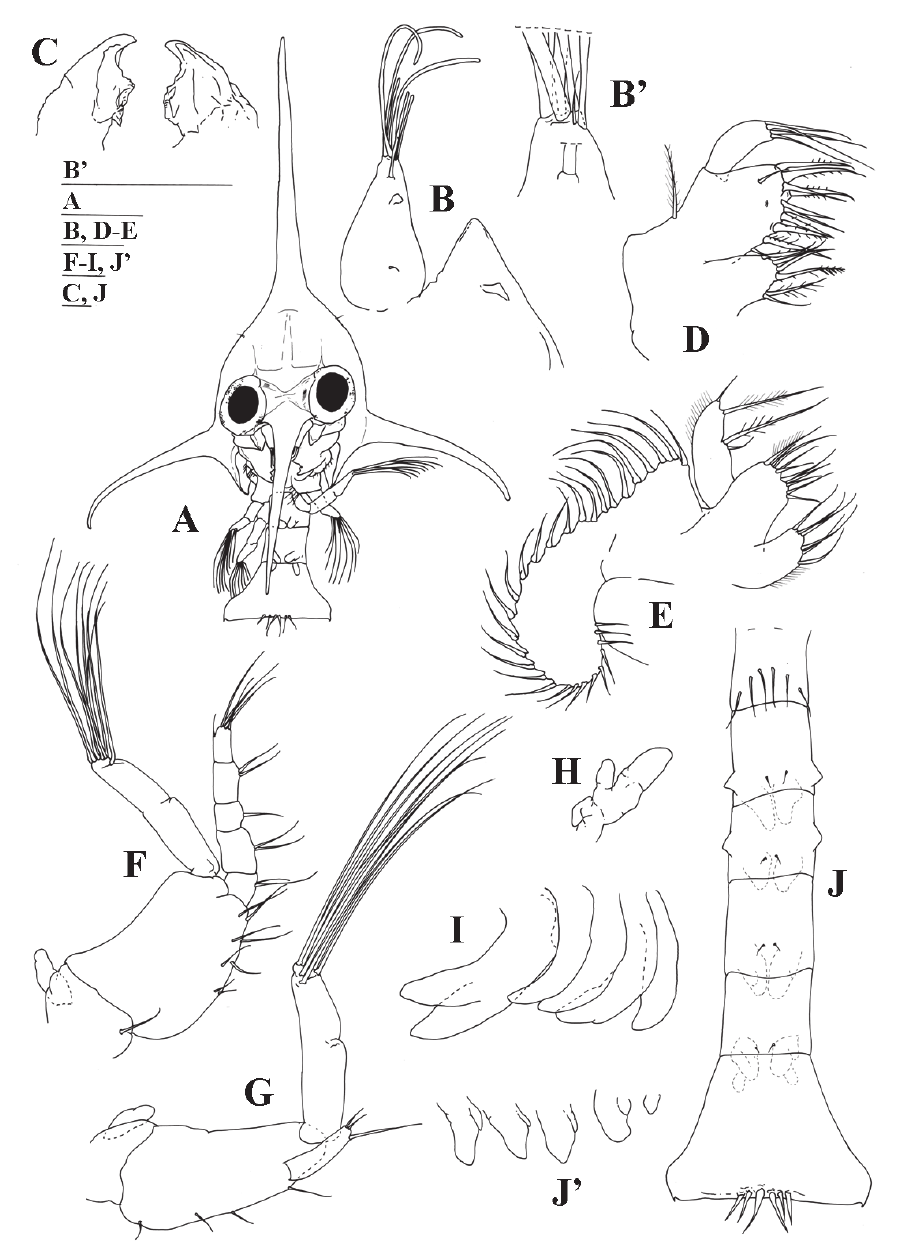
Fig . 3. – Ilia nucleus . third zoea: a, general aspect, frontal view; B, antennule and antenna; B’, detail of terminal aesthetascs and seta; C, mandibles; d, maxillule; e, maxilla; F, first maxilliped; g, second maxilliped; H, third maxilliped; i, pereiopods; J, dorsal view of abdomen and telson; J’, pleopods. scale bars: 0.1